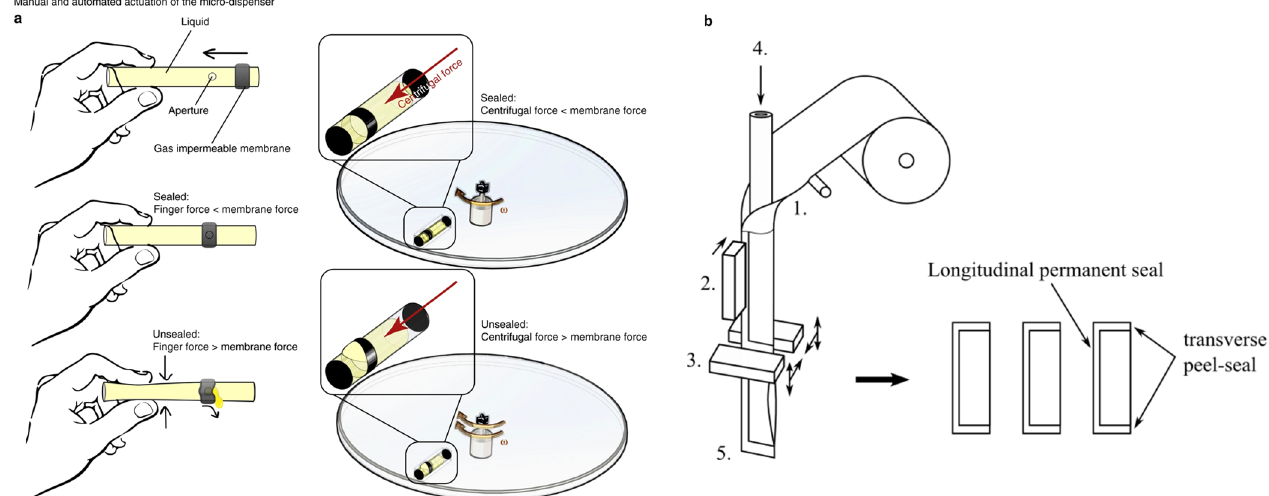
Figure 1. ( a ) Design of the “Flexpenser” pouch ‐ based valving system, showing its internal structure and dispensing mechanism. ( b ) Design of stickpacks. 1. Forming of a tube of the composite foil. 2. Longitudinal permanent sealing. 3. Transverse peel ‐ sealing. 4. Pump ‐ induced dispensing of liquids. 5. Cutting. Source: Reconstructed from publications [11,18]. Permission granted by the publisher.